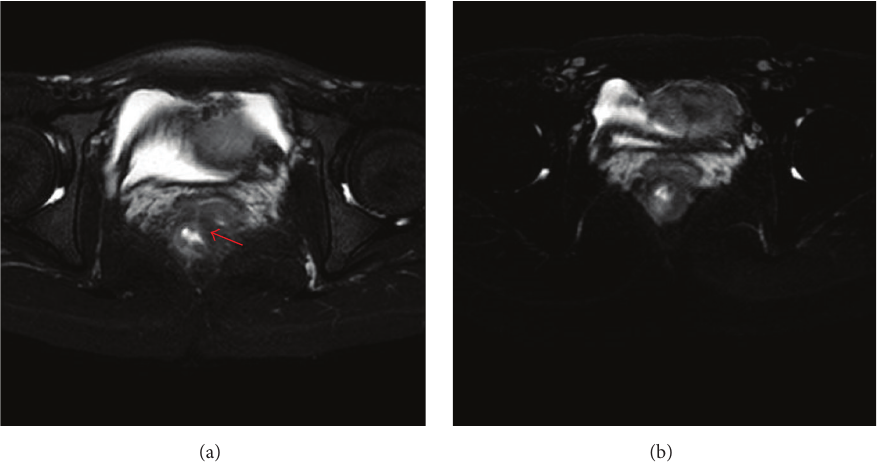
Figure 2: (a) Rectovaginal fistula before treatment (red arrow) of one case in the IFX treatment group; (b) rectovaginal fistula cured after the sixth course of IFX